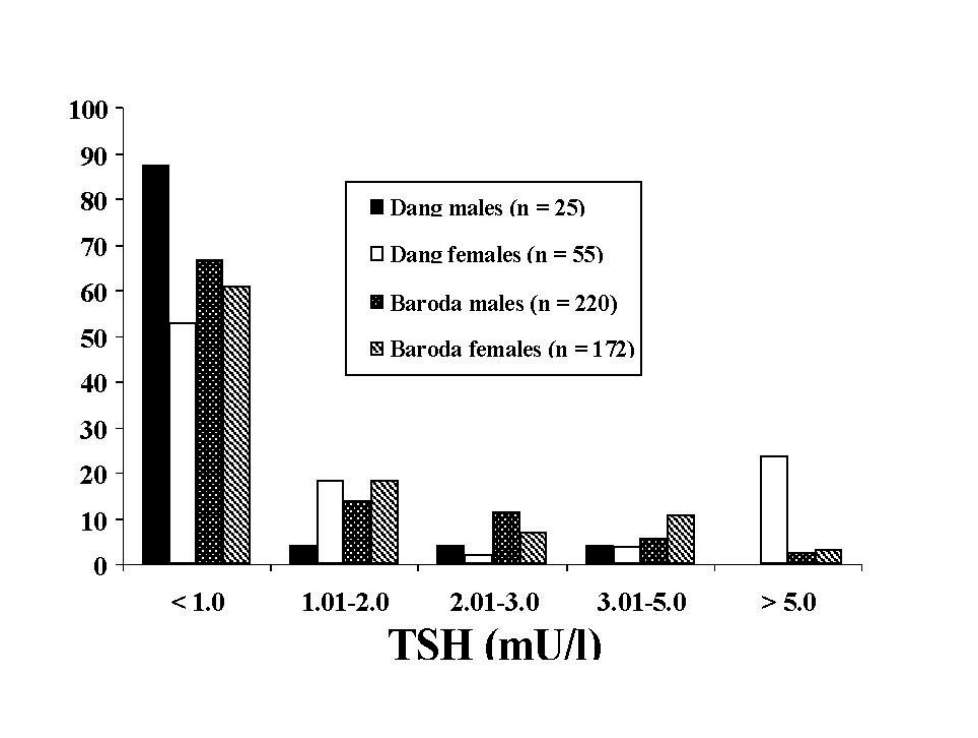
FIGURE 2. Frequency distribution of TSH (mU/l) in described ranges by gender in Dang and Baroda. The Y-axis represents the percentage of population.